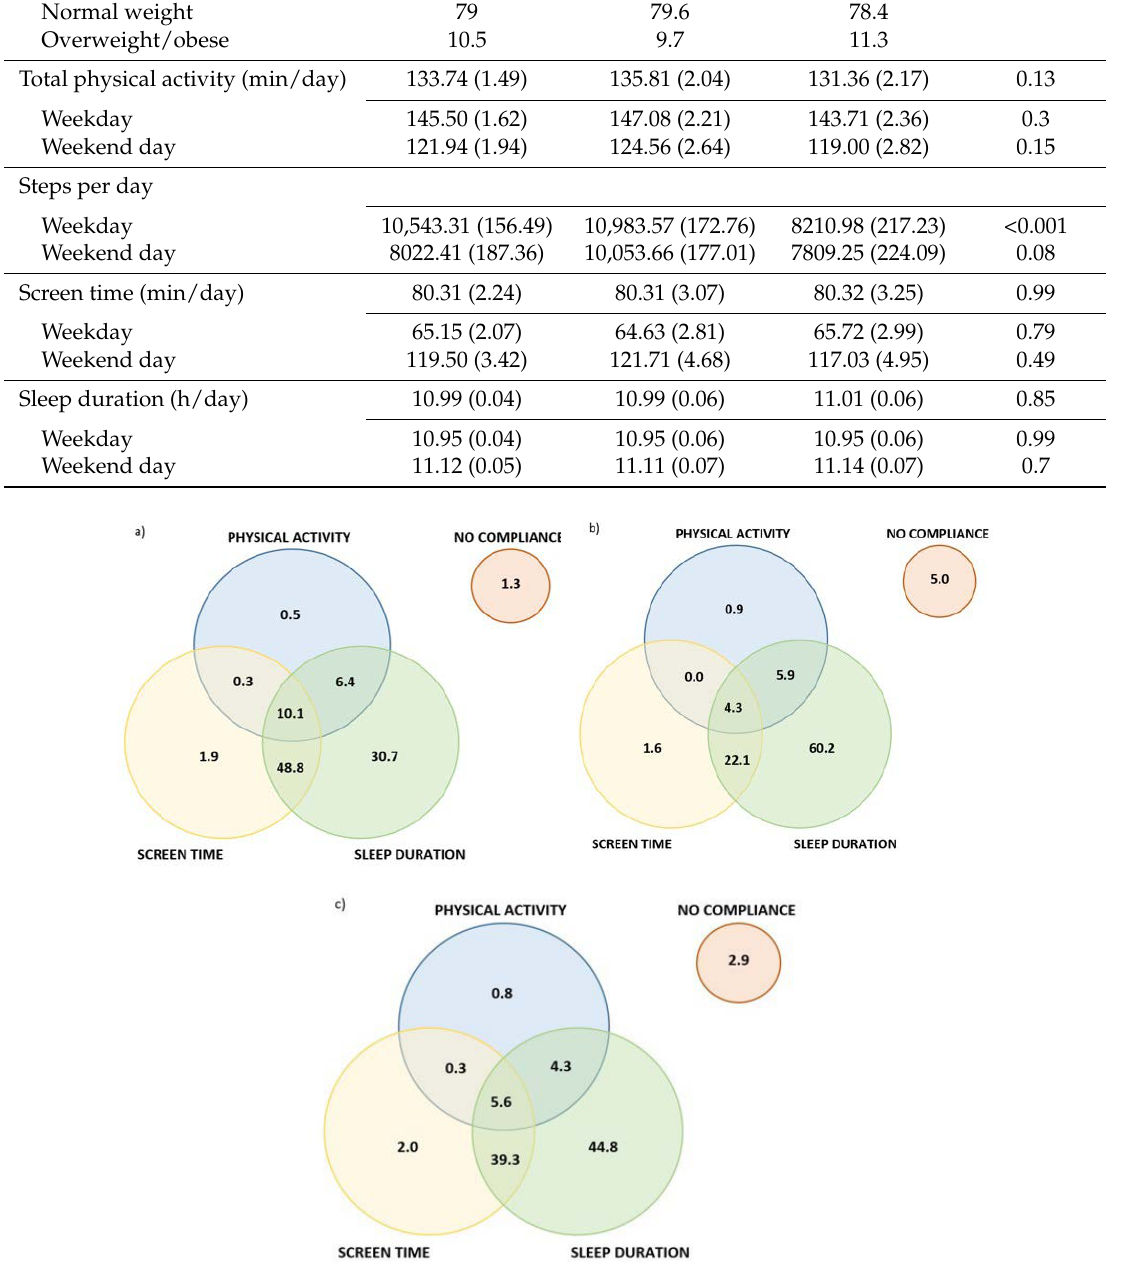
Figure 1. Venn diagrams showing the percentage of pre-school children (not) complying with the recommendations for physical activity, screen time, and sleep duration, and combinations of these recommendations, for ( a ) weekdays; ( b ) weekend days; and ( c ) overall. The sum of each circle is equivalent to the percentage of pre-school children meeting the individual recommendations (e.g., 17.3% for physical activity on